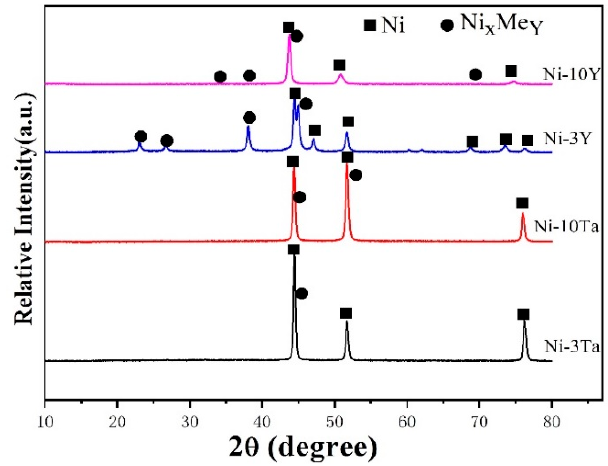
Figure 1. XRD patterns of the Ni ‐ based alloys with different compositions.